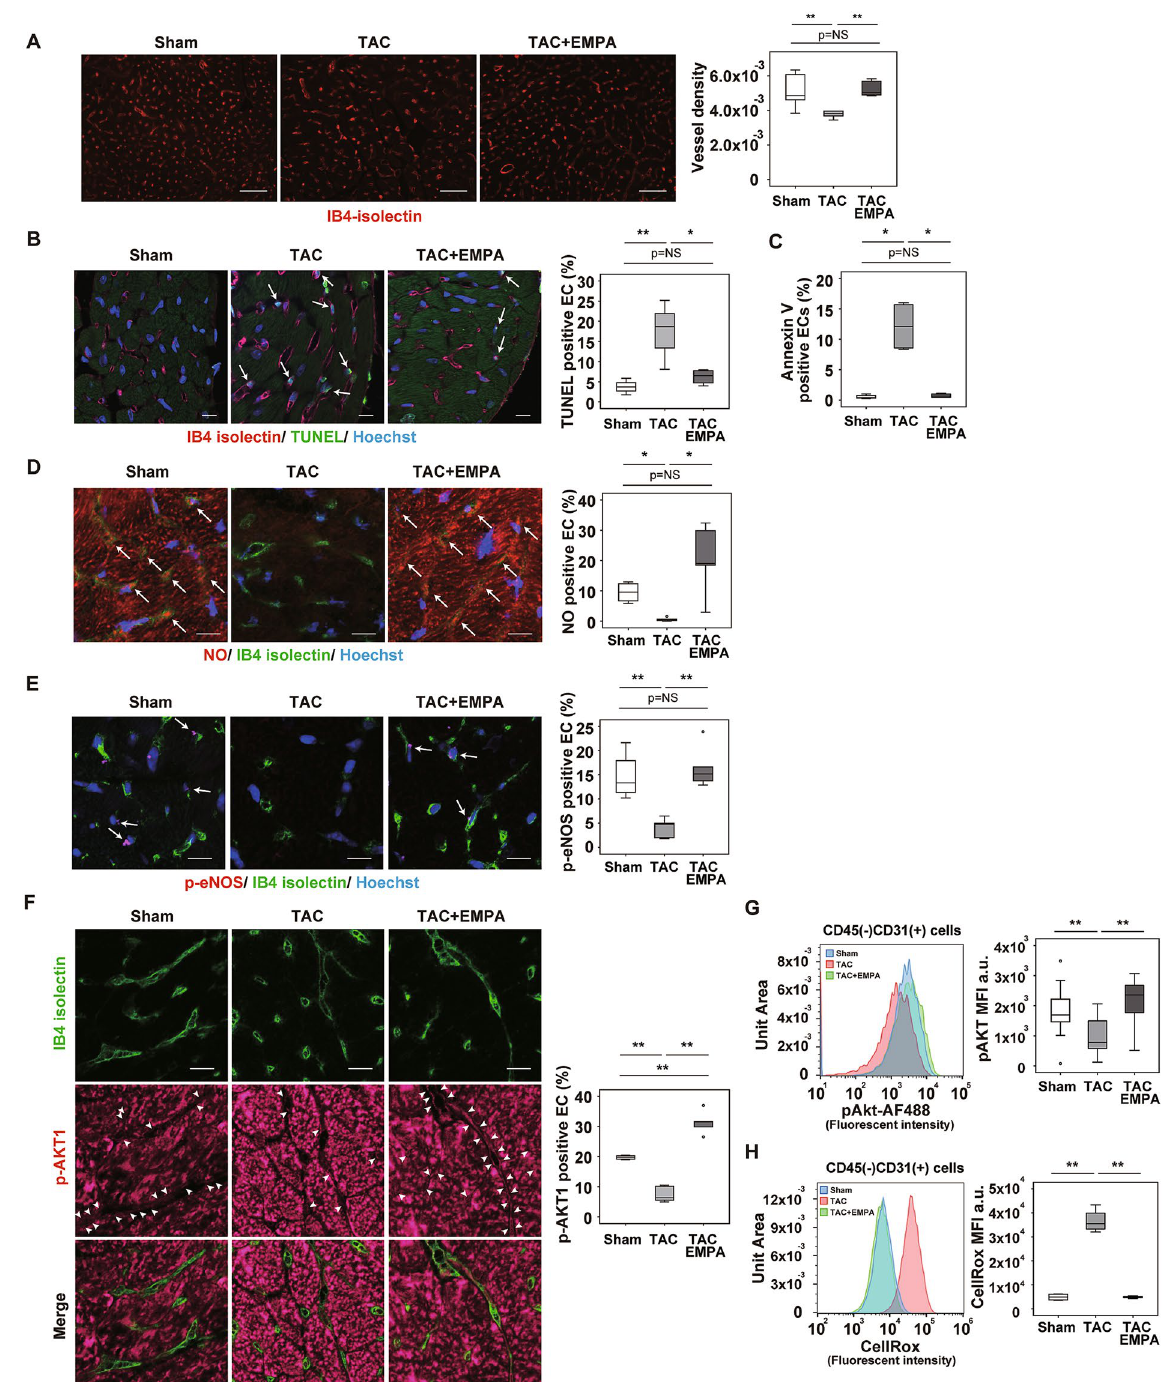
Figure 4. EMPA enhances capillarization in LV during pressure overload. ( A ) Capillarization of left ventricle (LV) of indicated mice as analyzed with IB4-isolectin staining. Right panel indicates vessel density (n = 6, 5, 5). Scale bar = 50 μm. ( B , D – F ): IB4-isolectin staining co-stained with TUNEL and Hoechst ( B ; scale bar = 10 μm; arrow indicates TUNEL-positive endothelial cells [ECs]); NO and Hoechst ( D ; scale bar = 10 μm; arrow indicates NO-positive ECs); p-eNOS ( E ; scale bar = 10 μm; arrow indicates p-eNOS positive ECs); and p-AKT1 ( F ; scale bar = 10 μm; arrow head indicates p-AKT1–positive ECs). Right panels indicate quantification ( B , n = 4, 4, 4; D , n = 4, 5, 5; E , n = 4, 5, 5; and F , n = 4, 5, 5). ( C , G , H ) Flow cytometry studies analyzing level of Annexin V ( C ) (n = 4, 4, 4), pAKT ( G ) (n = 14, 14, 14), and reactive oxygen species (CellRox) ( H ) (n = 4, 4, 4) in CD45 - CD31 + ECs extracted from cardiac tissues of indicated mice. Data were analyzed by 2-way analysis of variance (ANOVA) followed by Tukey’s multiple comparison test ( A , B , D – H ), or Kruskal Wallis correction ( C ). * P < 0.05, ** P < 0.01. Values are shown as the mean ± SEM. NS not significant. Small circle indicates outlier, triangle indicates abnormal value. Analyses were performed with and without these values; when the results of both analyses were nonsignificant, the difference was described as